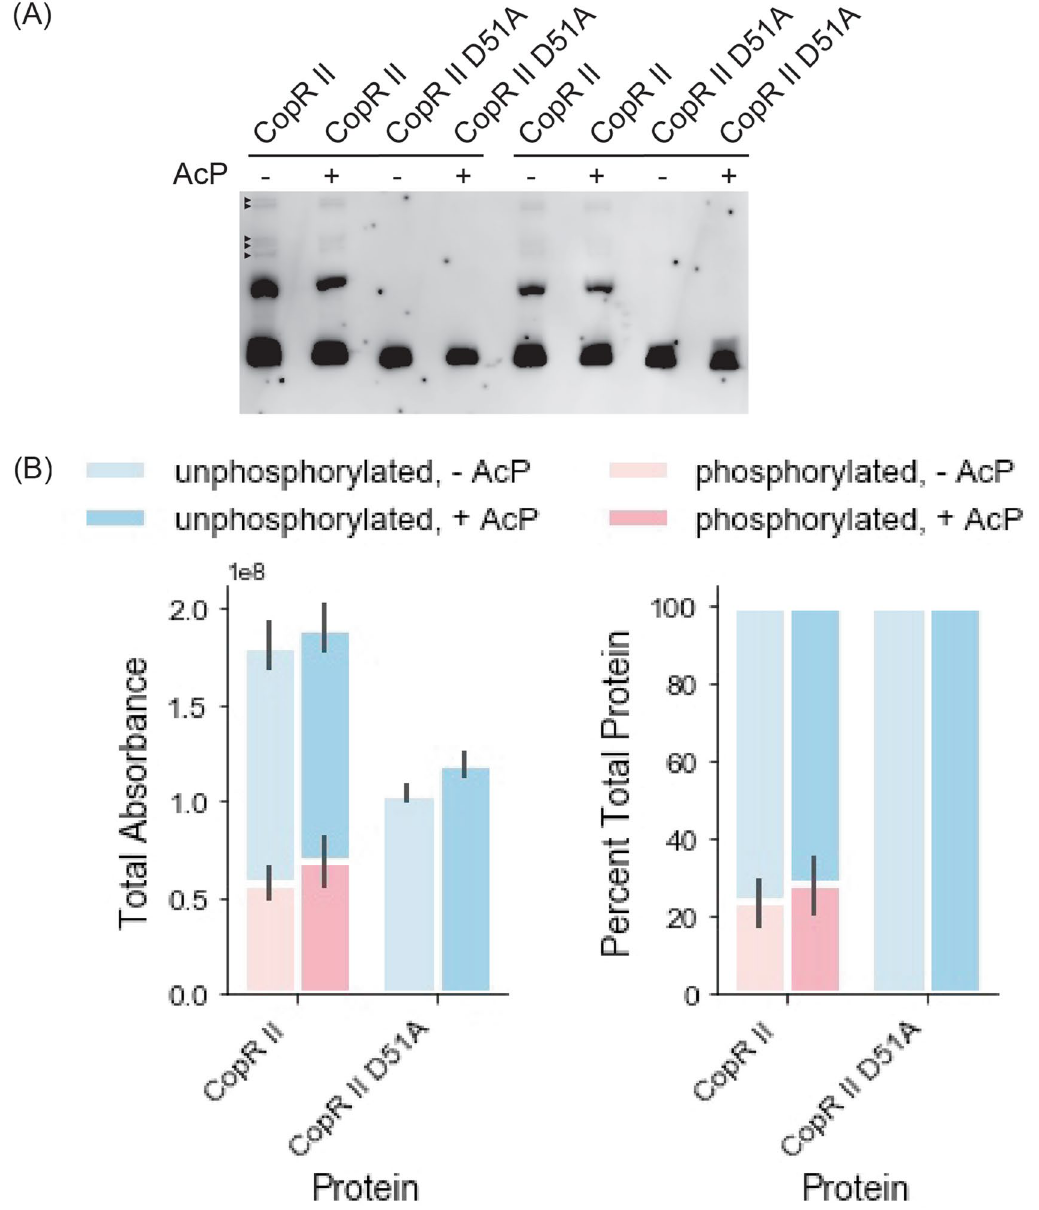
Figure 2. Phos-tag characterization of recombinant CzcR and CopR II ( A ) Representative phos-tag result with recombinant CopR II and CopR II D51A. Primary bands were quantified, ambiguous bands that could be the result of co-purified background proteins or protein dimers are marked by small black triangles. ( B ) Quantitation of unphosphorylated (blue) and phosphorylated (red) bands for CopR II, and CopR II D51A with and without phospho-donor AcP. Bars and error bars represent the averages and standard errors between the average of two technical